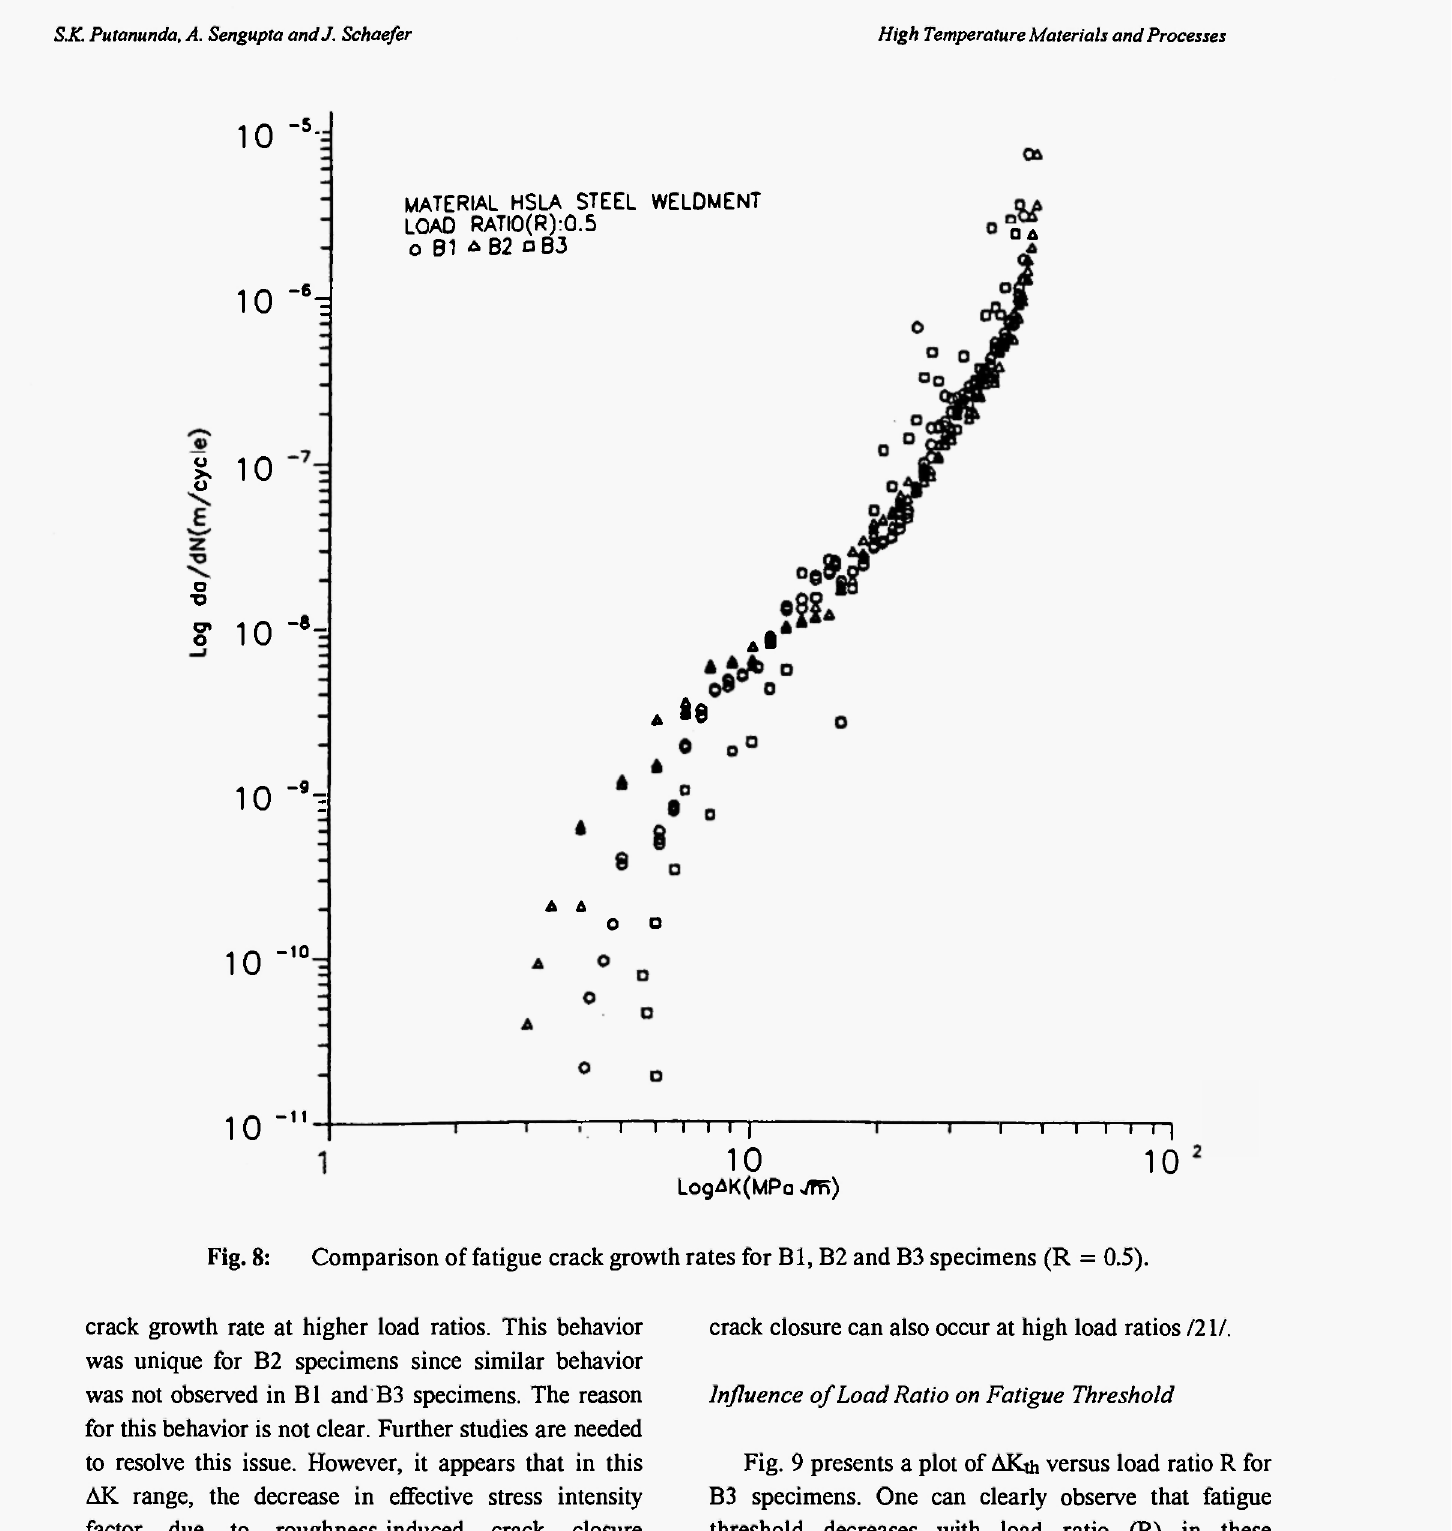
Fig. 8: Comparison of fatigue crack growth rates for Bl, B2 and B3 specimens (R = 0.5). crack closure can also occur at high load ratios